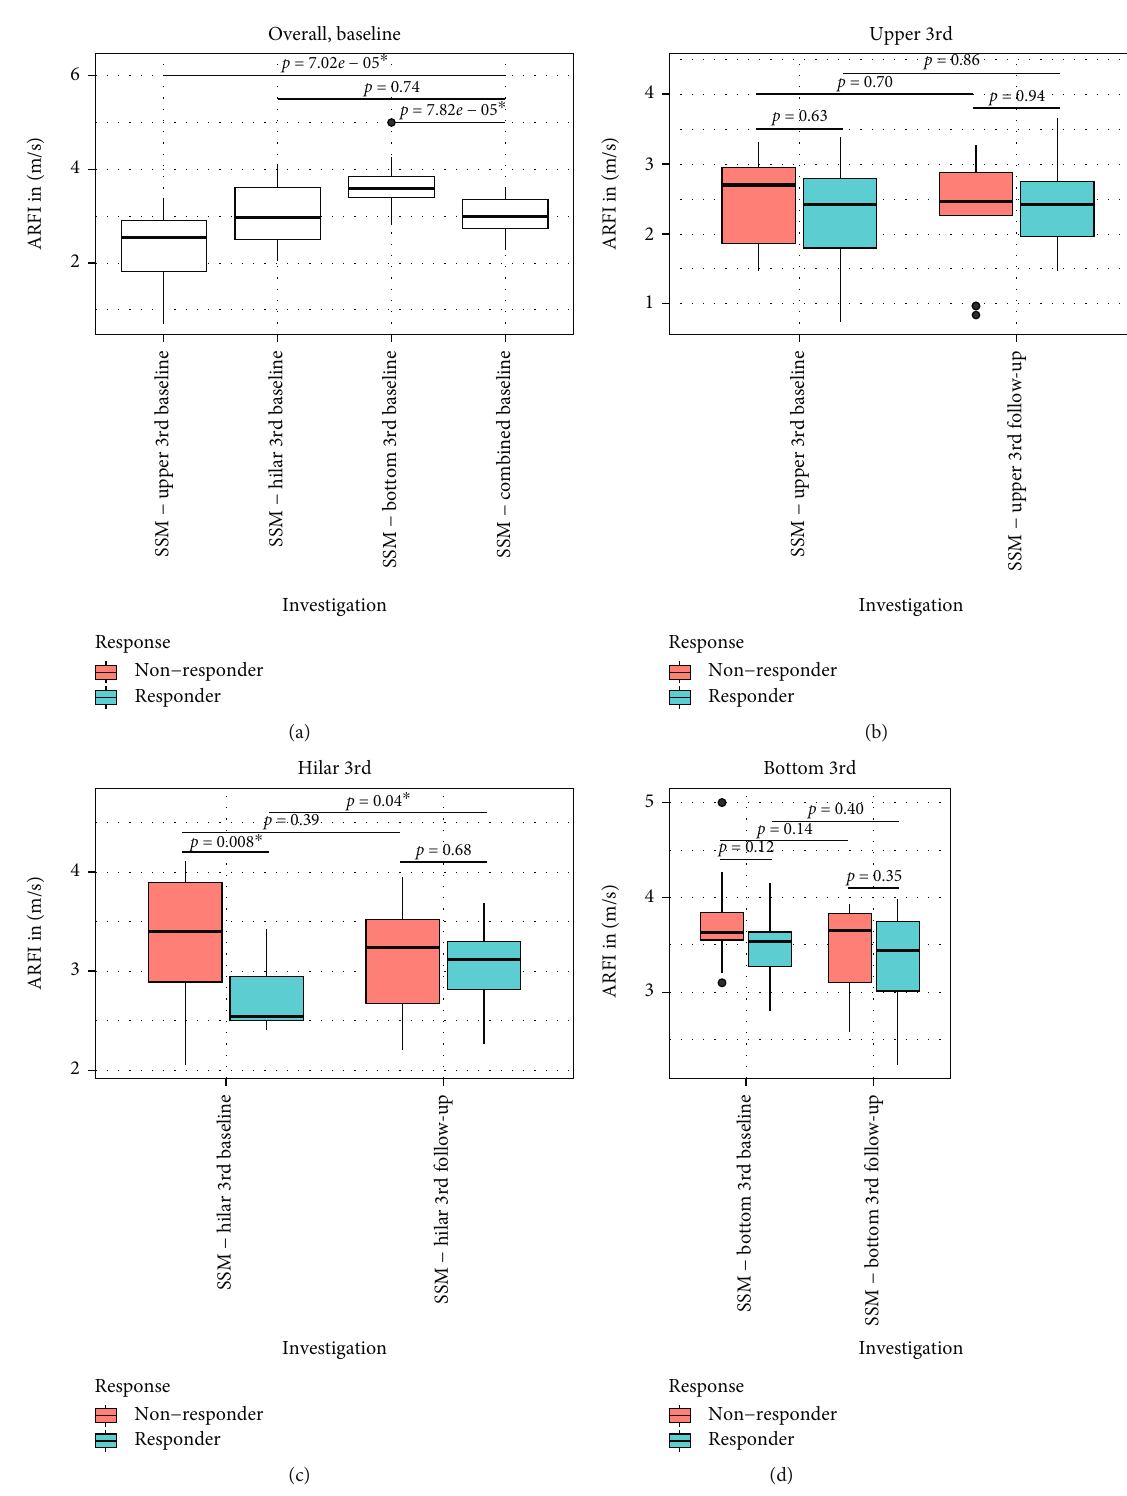
Figure 5: ARFI elastography results for spleen sti ff ness evaluation: results of SSM investigations performed on three de fi ned spots of the spleen showed signi fi cant di ff erences between the three positions in the spleen investigated (a). The results of spleen elastography investigations in the upper, hilar, and bottom third, respectively (red=baseline, blue =follow-up, ∗ =signi fi cant result) did not show a signi fi cant reduction of spleen sti ff ness in the response group (b/c/d) (ARFI =acoustic radiation force impulse imaging; SSM=spleen sti ff ness